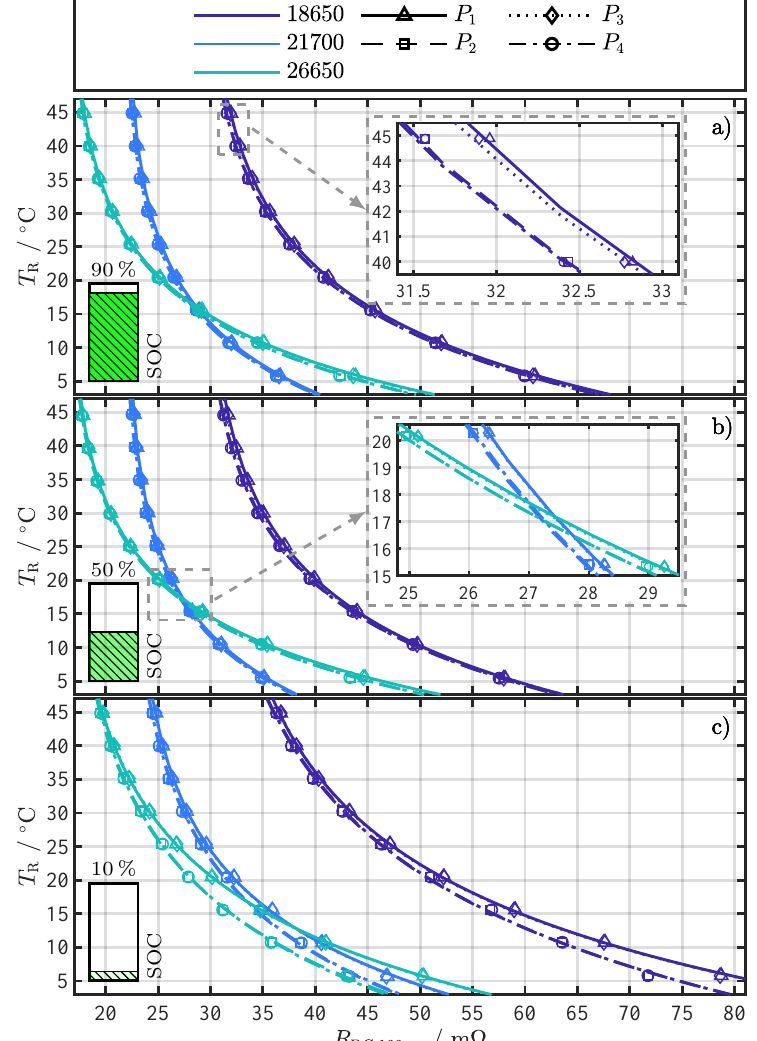
Figure 2. Exemplary fitting results of Equation (4) for ∆ t = 100ms for different cell formats and current changes P 1 to P 4 (see pulse pattern in Figure 1b) at the investigated SOCs ( a ) 90%, ( b ) 50%, and ( c ) 10%. The marker type represents the averaged value from the repeated pulse pattern (360 values) at each temperature point. The close-ups in ( a , b ) visualize the minimal difference between current changes P 1/3 and P 2/4